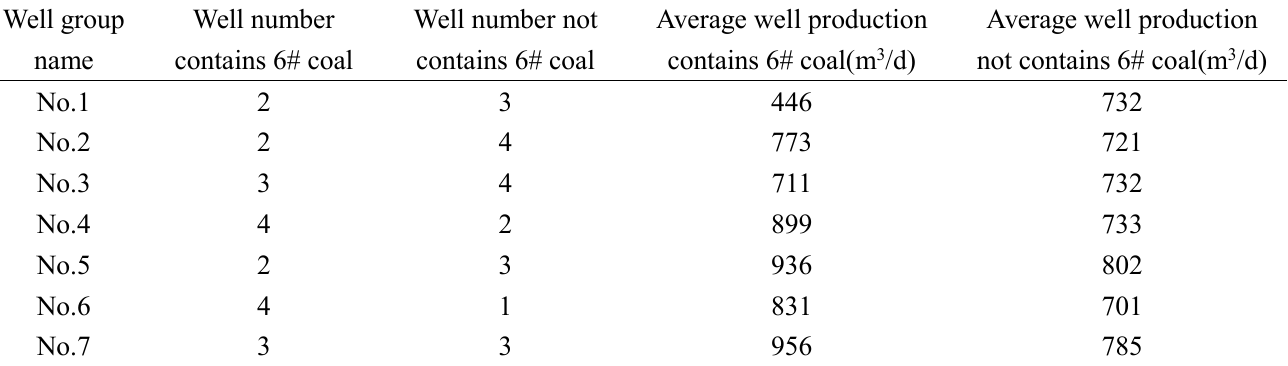
Table 2—The comparison of well production contains 6# coal and not contains 6# coal.